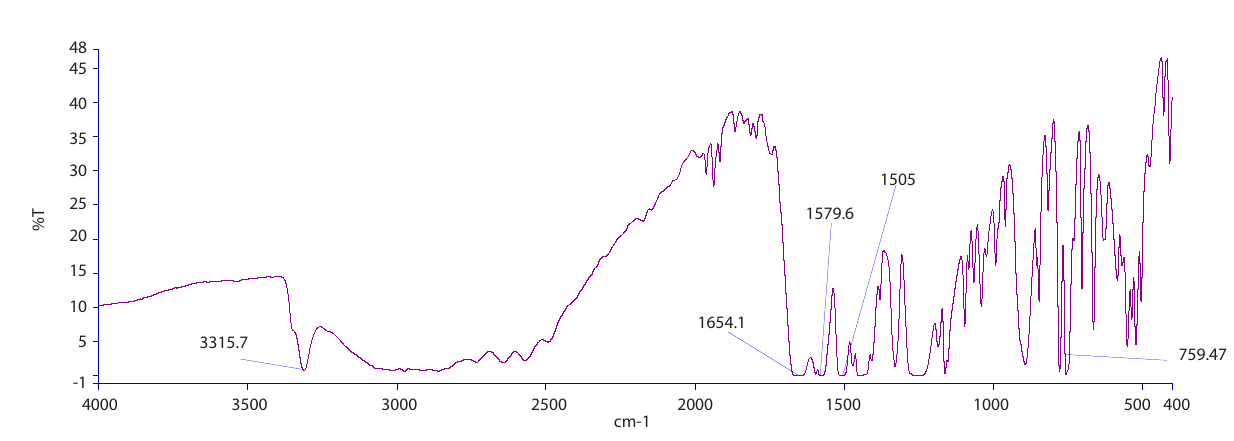
FIGURE 6 - FTIR spectra of mefenamic